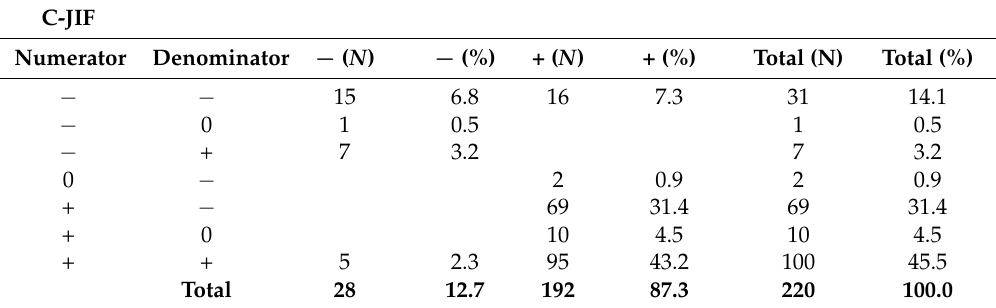
Table 2. Distribution of the numbers ( N ) and percentages (%) of transitions according to the mechanism of change involved in the variable C-JIF. Symbols: - Decrease; + Increase; 0 No change. Empty cells represent instances that are not possible according to the JIF definition.